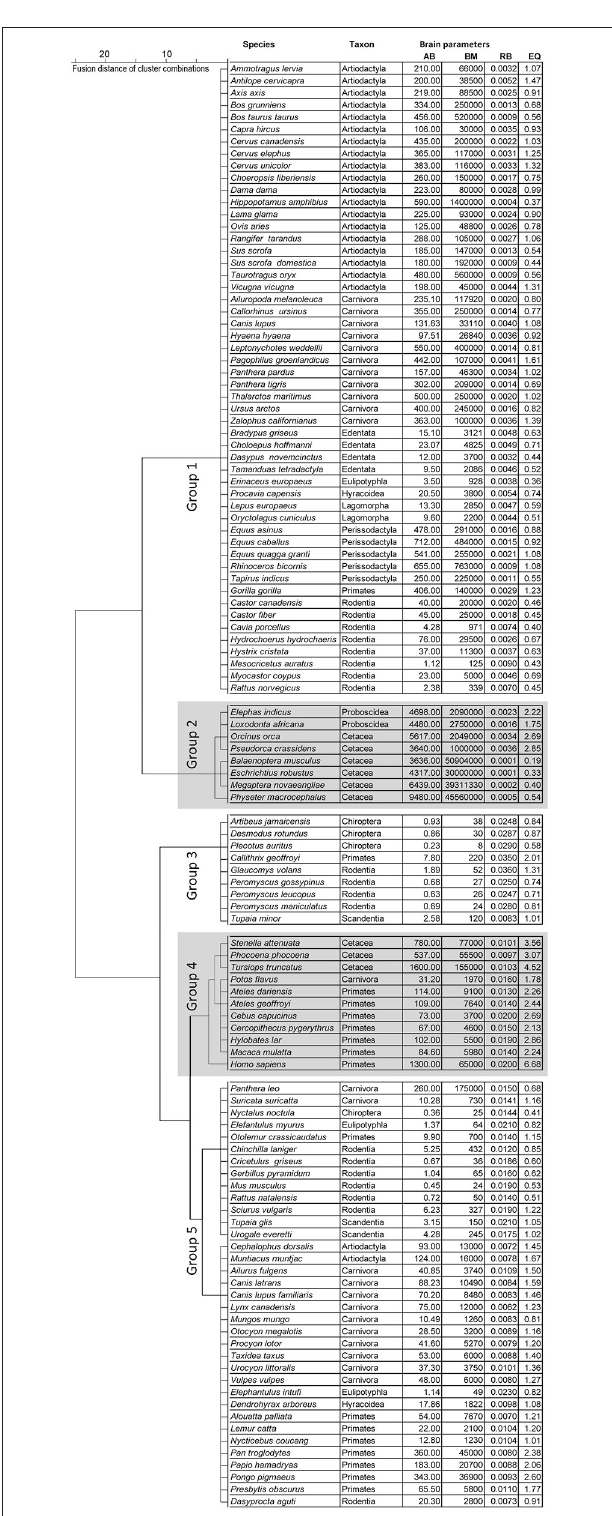
FIGURE 1 | Dendrogram of the cluster analysis for the three brain dimensions absolute brain mass (AB), relative brain mass (RB), and encephalization quotient (EQ) subdivided into five endclusters (groups